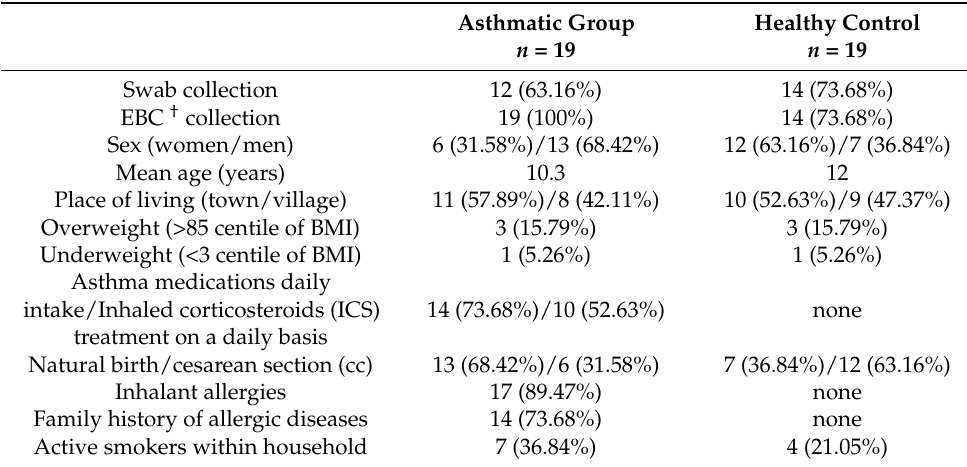
Table 1. Study group